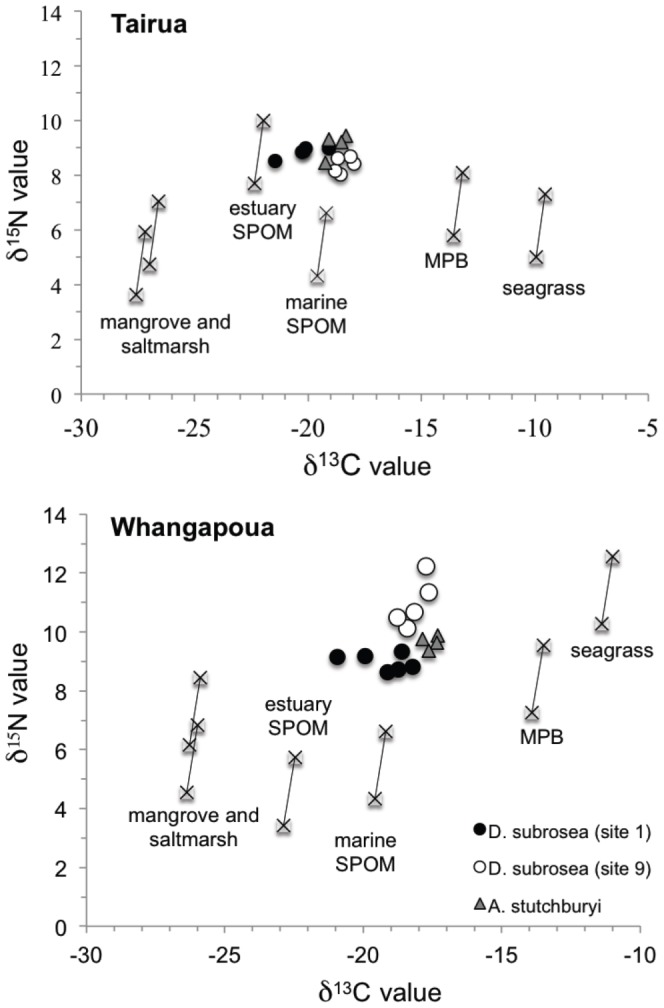
Dual isotope (δ13C, δ15N) plots of estuarine primary producers (crosses) and predicted fractionation associated with one trophic level for Tairua and Whangapoua estuaries.
Dosinia subrosea (foot muscle) from site 1 closest to the estuary mouth are presented as solid circles and from site 9 as empty circles. For comparative purposes, the isotope values of a suspension-feeding bivalve, Austrovenus stutchburyi, within each estuary are presented as grey triangles.